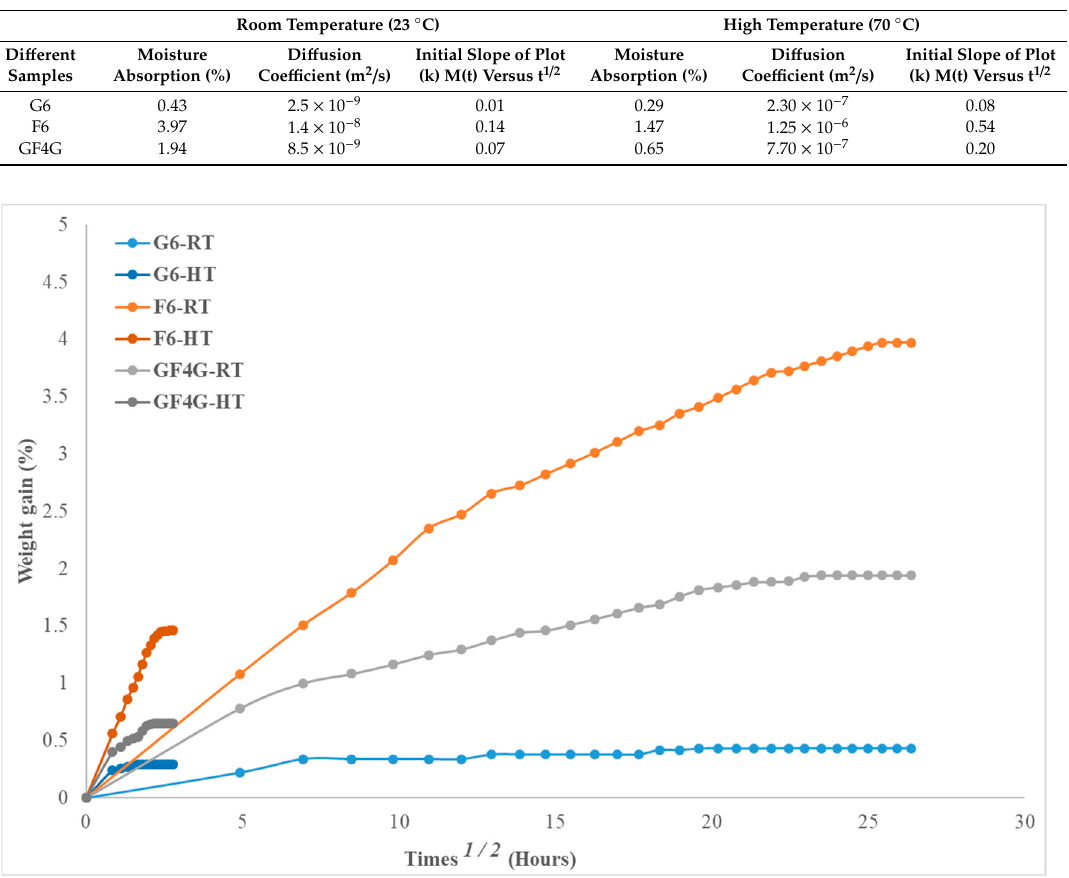
Table 1. Moisture uptake and diffusion coefficient results.